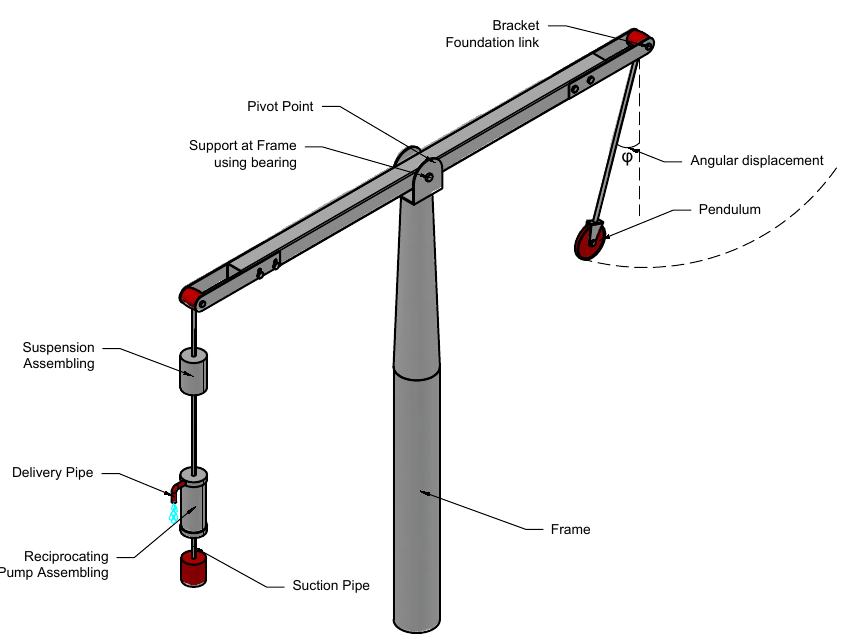
Figure 3. Configuration of the three-dimensional model of the investigated